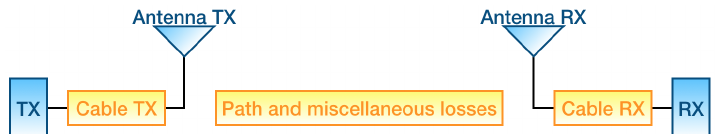
Figure 1. Gains, in blue, and losses, in yellow, of a communication channel to be accounted within link budget